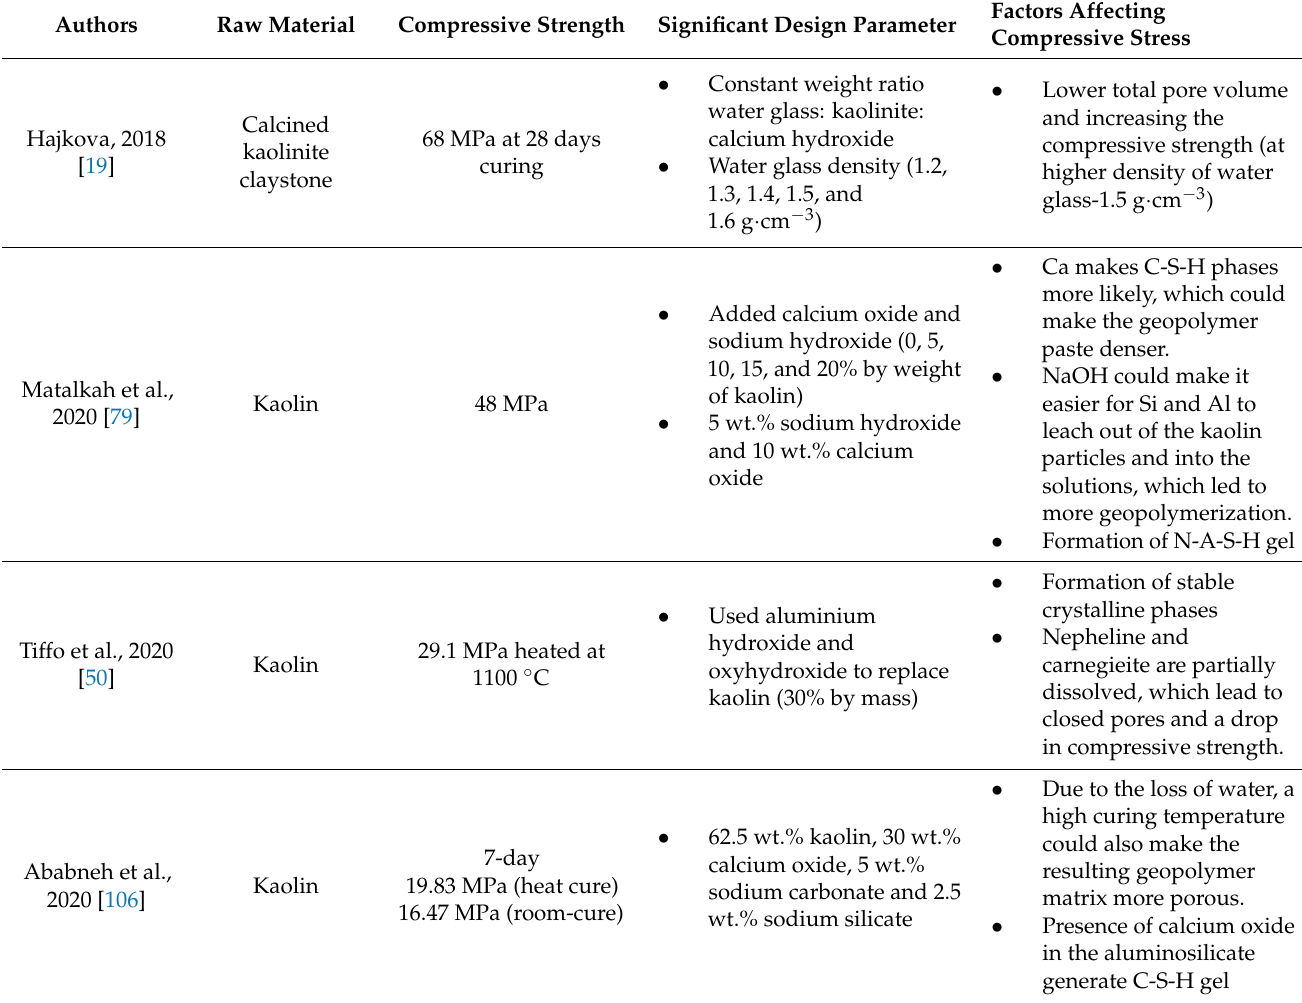
Table 6. Compressive strength and factors